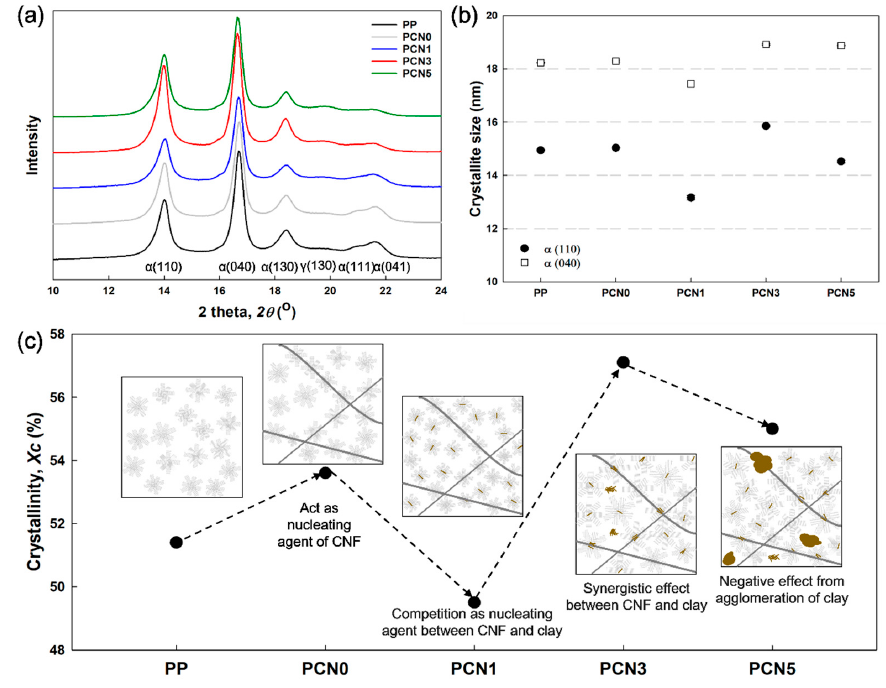
Figure 8. ( a ) XRD spectra of PP, PP / CNF, and PP / CNF / nanoclay nanocomposites in high 2 θ range; ( b ) calculated crystallite size based on the XRD spectra; ( c ) Xc and predictable morphology structures. Table 4. Mechanical properties of PP, PP / CNF, and PP / CNF / nanoclay nanocomposites.